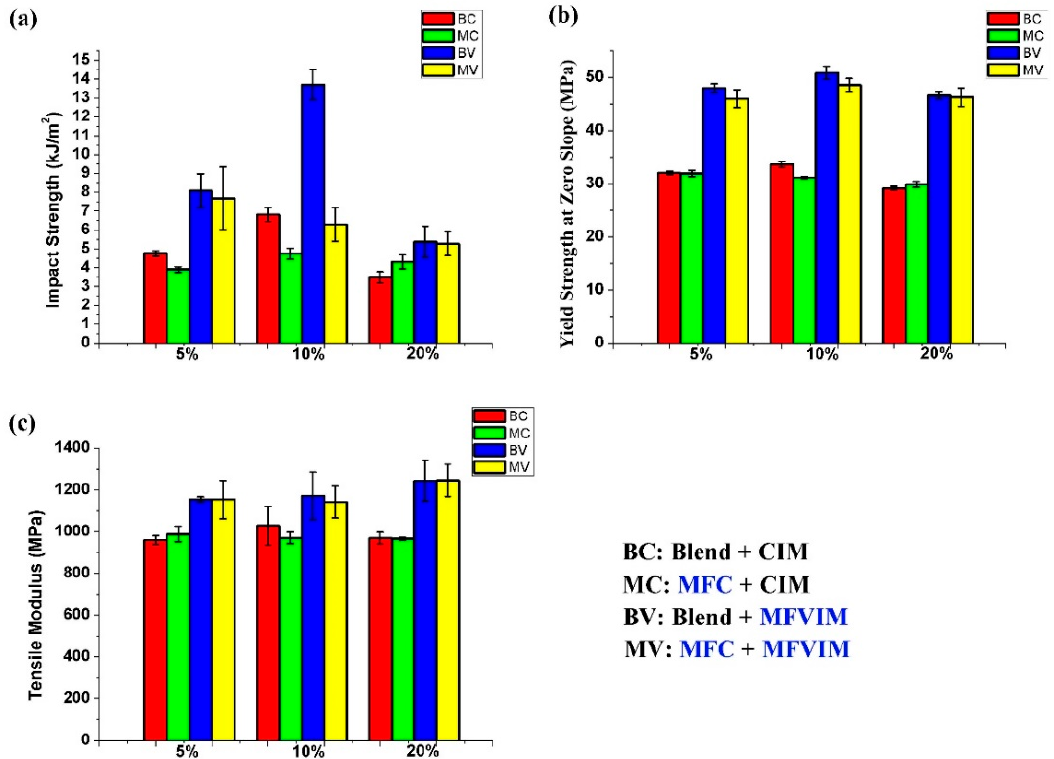
Figure 5. Mechanical properties of various samples. ( a ) Impact strength, ( b ) yield strength at zero slope, and ( c ) tensile modulus.